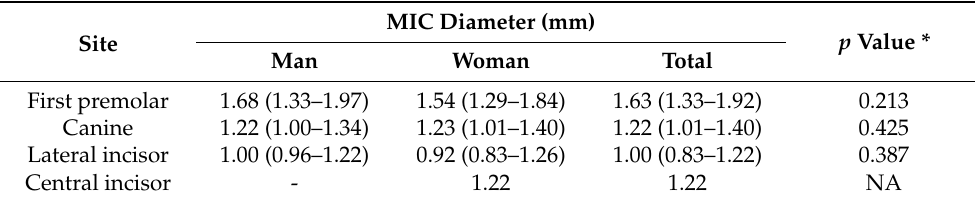
Table 2. The MIC diameter at the four anatomical reference levels.